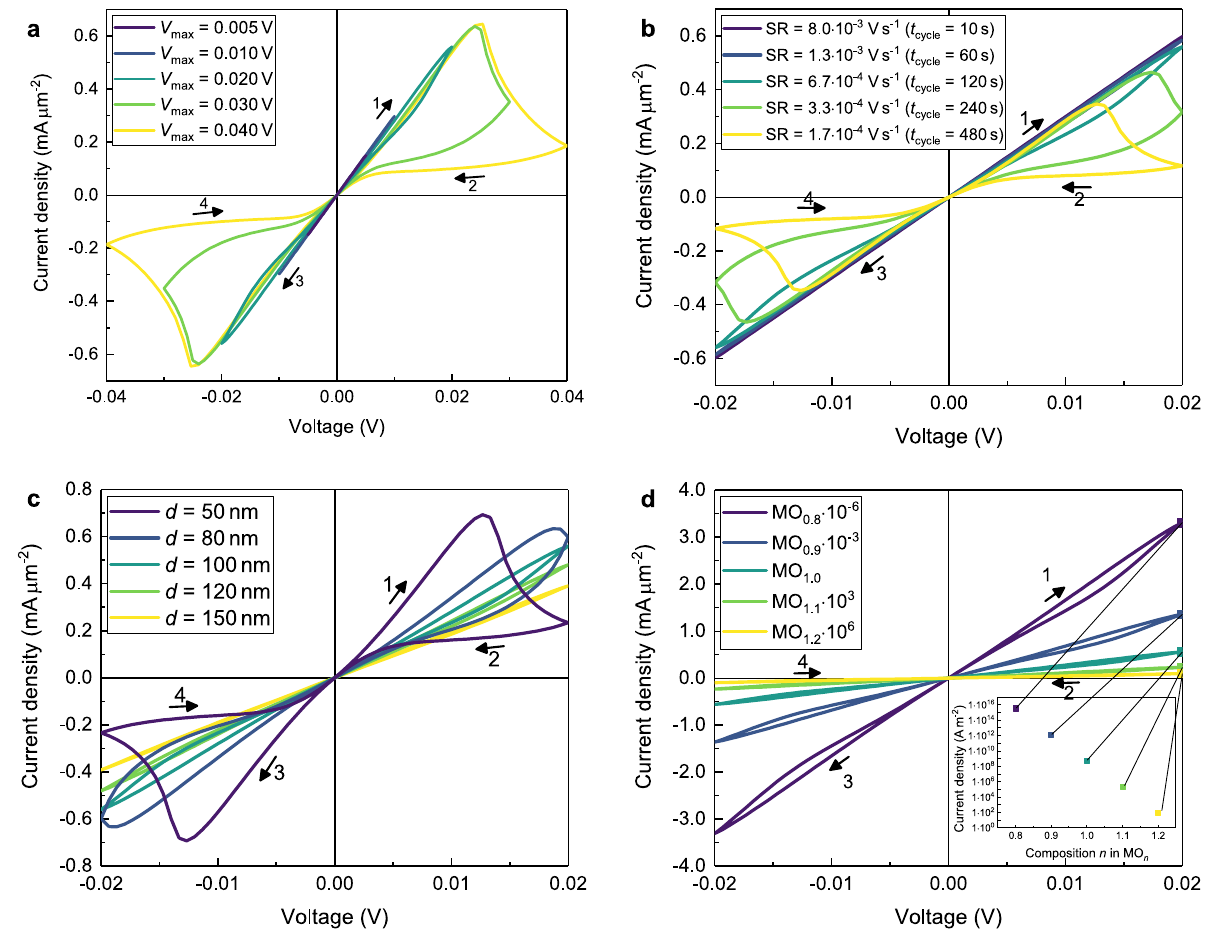
Figure 5. I–V curves for 1D-simulations with parameters from Table 1. ( a ) Variation of the maximum voltage V max . ( b ) Variation of the sweeprate SR. ( c ) Variation of the sample’s thickness d . ( d ) Variation of the initial composition n 0 . In order to show all graphs in the same window they are scaled by the factor stated in the legend. The inset shows the unscaled current densities at the voltage of 0.02